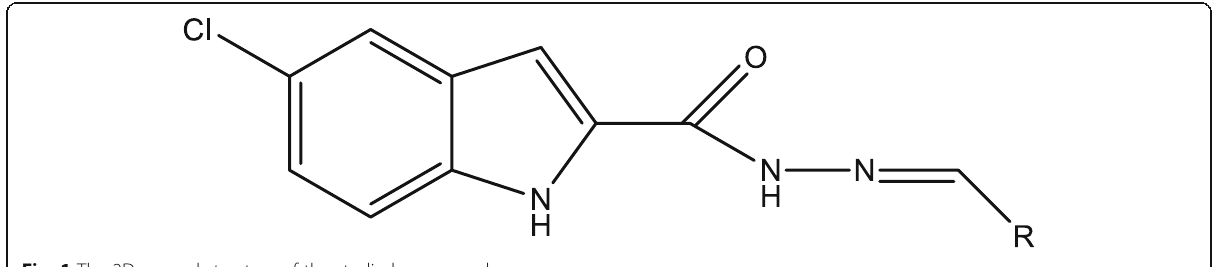
Fig. 1 The 2D general structure of the studied